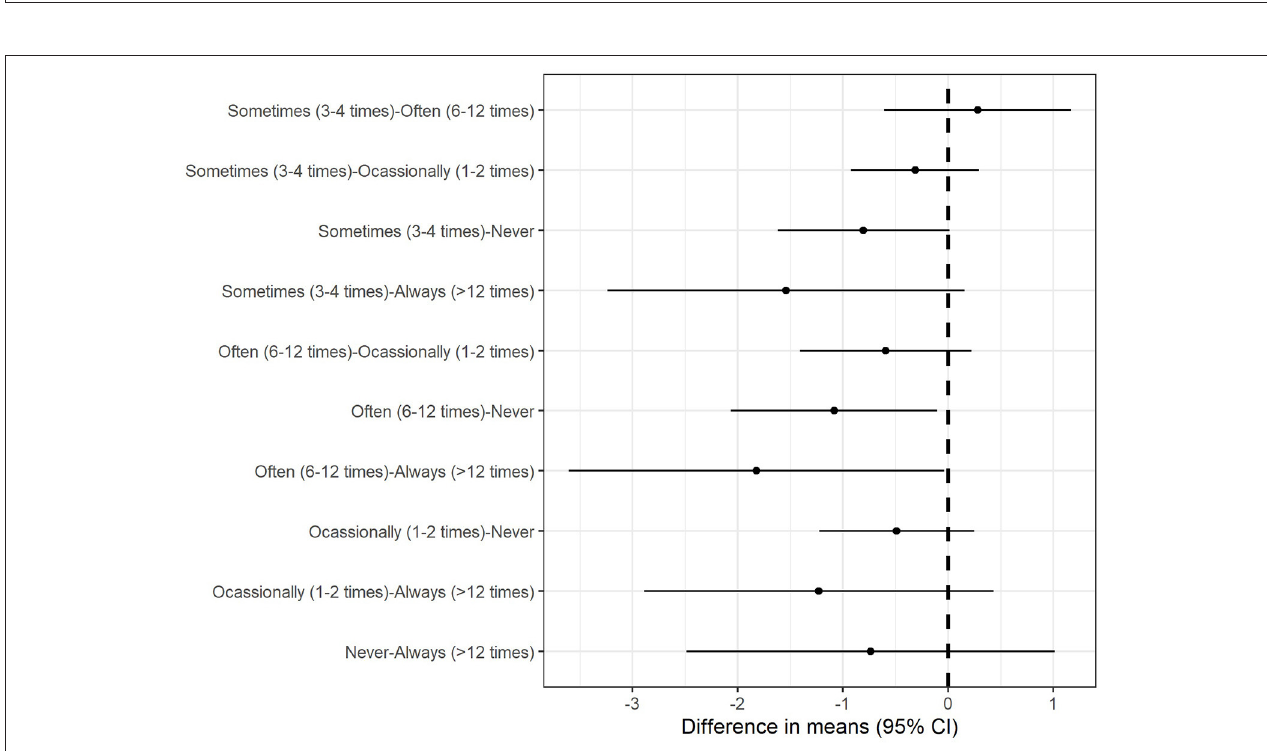
FIGURE 3 | Marginal mean differences in trust for frequency of doctor visits. Individuals who had moderate face-to-face doctor–patient visits had lower trust in doctors than those who never or always visited the doctors face-to-face during the COVID-19.